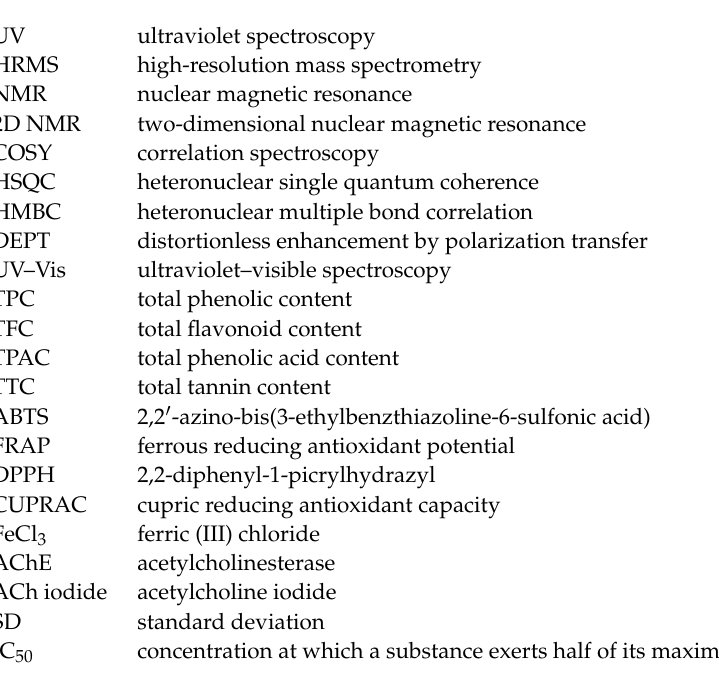
UV with crucial MS chromatogram of extract HP3 obtained by LC-PDA-HRMS. Figure S40: The UV chromatogram of fraction HP4 obtained by LC-PDA-HRMS. Figure S41: The UV with crucial MS chromatograms of fraction HP5 obtained by LC-PDA-HRMS. Figure S42: The UV chromatogram of extract HP6 obtained by LC-PDA-HRMS. Figure S43: The UV chromatogram of extract HP7 obtained by LC-PDA-HRMS. Figure S44: The UV with crucial MS chromatograms of fraction HP8 obtained by